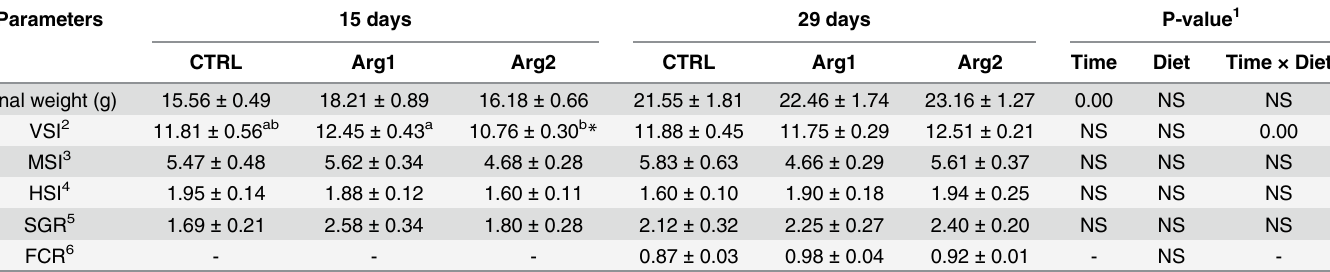
Table 4. Data on the performance of European sea bass sampled 15 or 29 days after being fed three different diets. Values are means ± SEM (n = 10) Parameters 15 days 29 days P-value 1 CTRL Arg1 Arg2 CTRL Arg1 Arg2 Time Diet Time × Diet